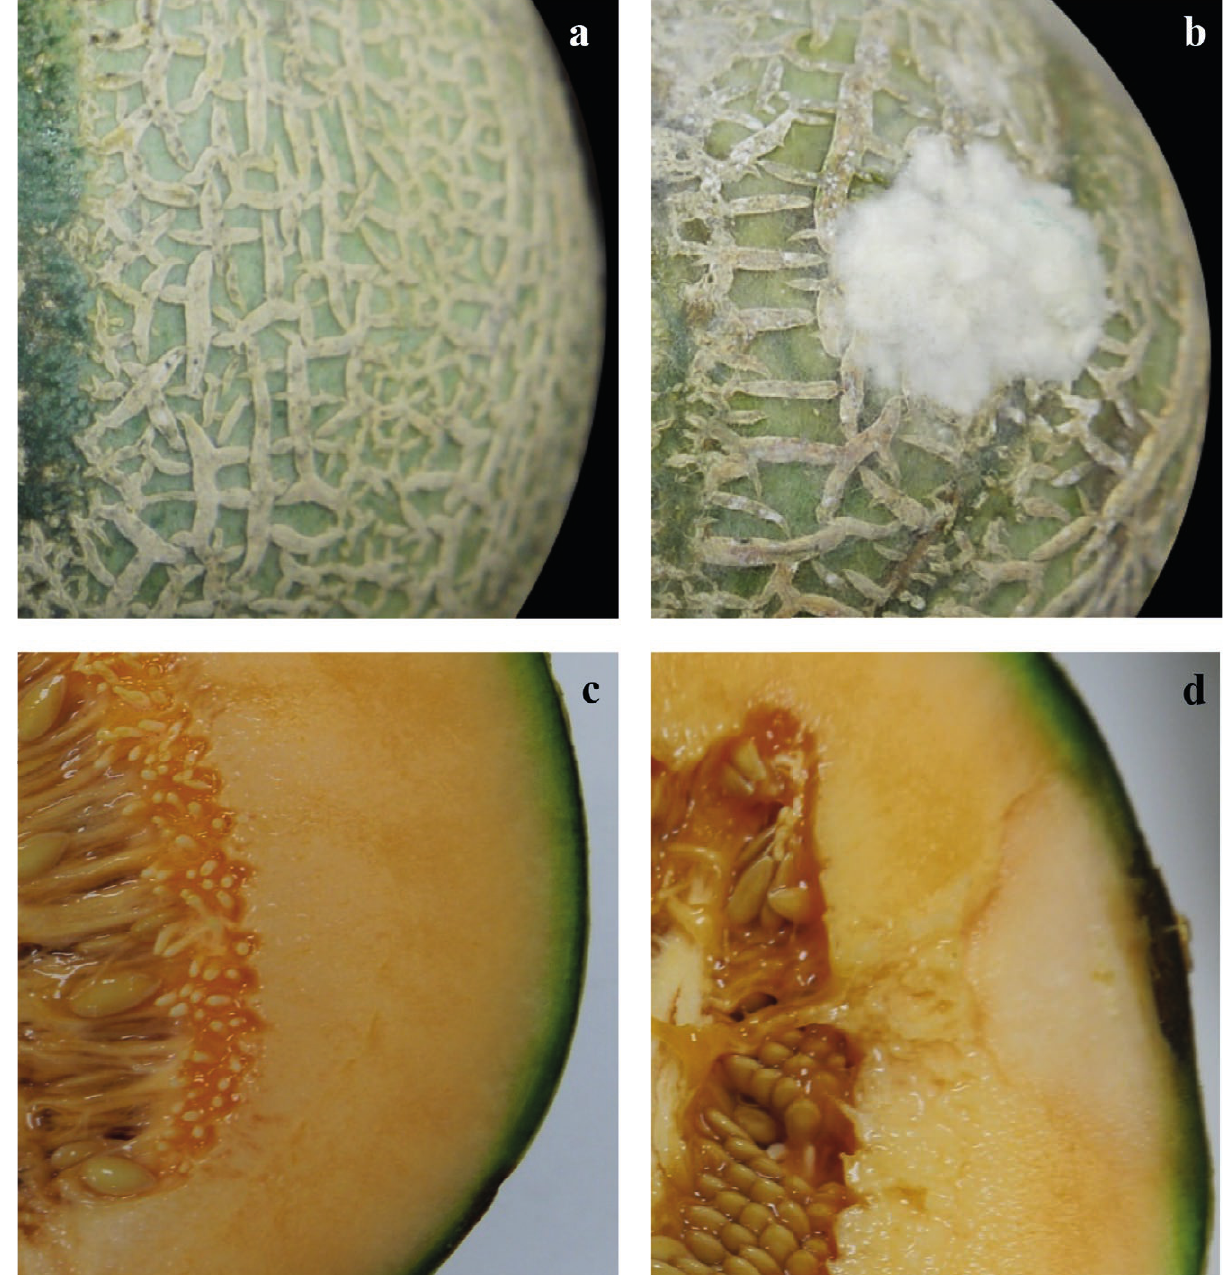
Figure 2. Morphological changes in cantaloupe ( Cucumis melo var. cantalupensis ) fruits, in pathogenicity tests 7 days aft er inoculation with Fusarium annulatum . a and c, Control fruit inoculated with sterile distilled water. b and d, Fruit inoculated with F. annulatum isolate